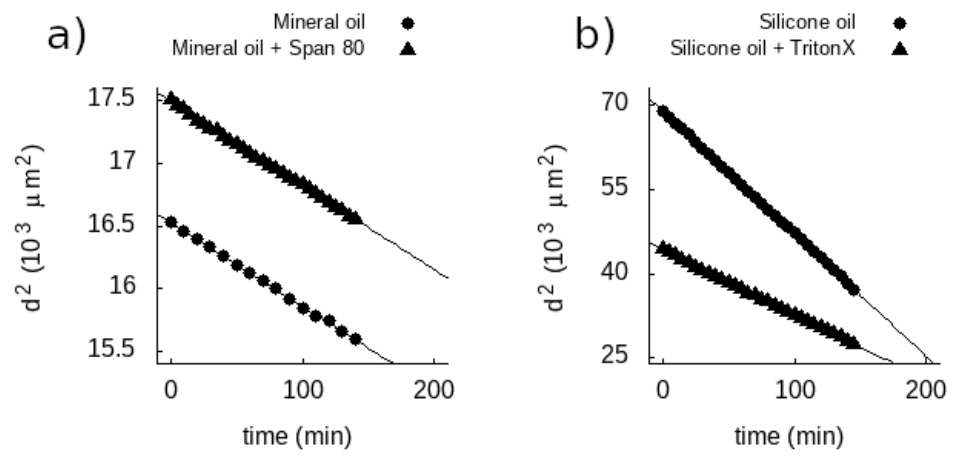
Figure 6. Square of the droplet diameter d 2 ( t ) as a function of time in phase 1 measured on an inverted microscope. ( a ) d 2 ( t ) curves for representative droplets in mineral oil and mineral oil mixed with surfactant (Span80). ( b ) d 2 ( t ) curves for representative droplets in silicone oil and silicone oil mixed with surfactant (Triton X-100). Data series were fit with a line. Relative standard error of the slope was <1% in all